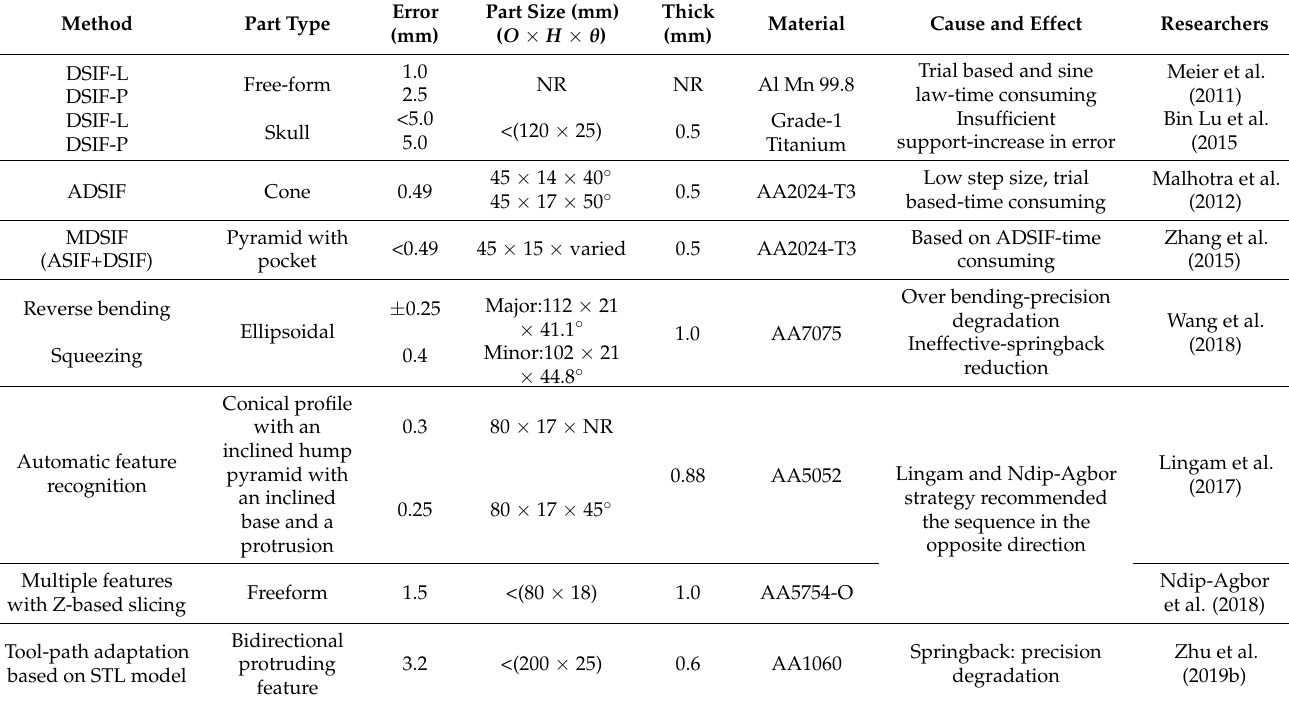
Table 2. Accuracy improvements based on tool-path